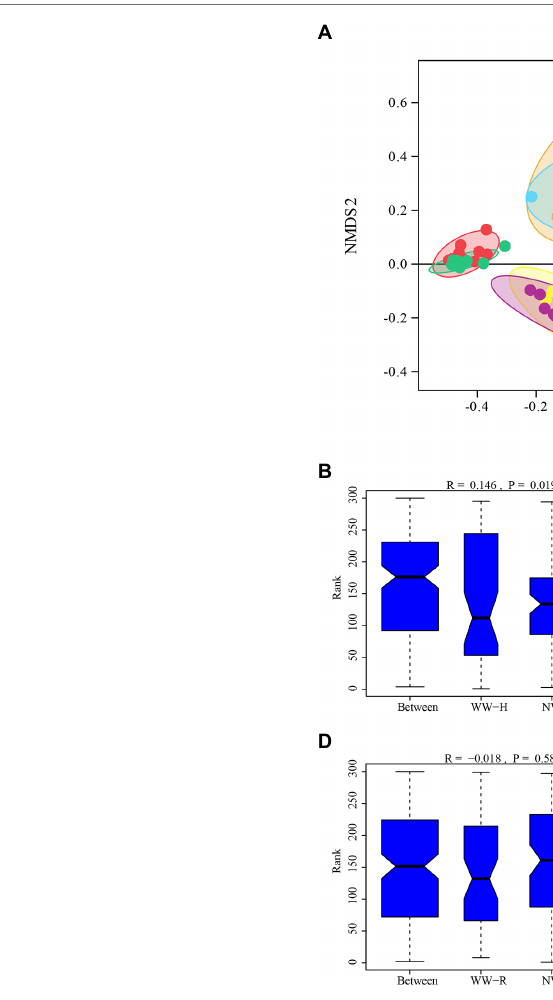
FIGURE 6 | Beta diversity of the bacterial communities in each sample. (A) Non-Metric Multidimensional Scaling (NMDS) analysis of the bacterial community structure based on Bray–Curtis dissimilarity at the OTU level; (B) ANOSIM analysis of WW-H and NW-H; (C) ANOSIM analysis of the sapwood from wetwood trees (WW-S) and the sapwood from healthy trees (NW-S); (D) ANOSIM analysis of root tissue from wetwood trees (WW-R) and root tissue from healthy trees (NW-R); and (E) ANOSIM analysis of rhizosphere soil from wetwood trees (WW-SP) and rhizosphere soil from healthy trees